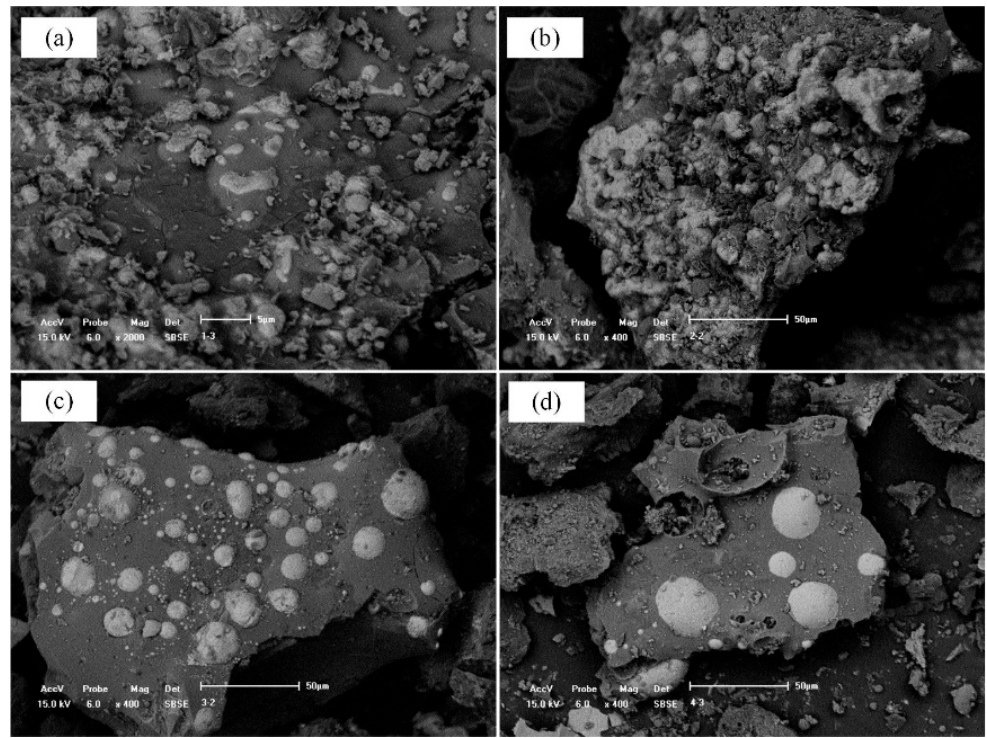
Figure 8. SEM images of coal-based reduction samples at 1573 K. ( a ) 10 min ( b ) 20 min ( c ) 40 min ( d ) 60 min.